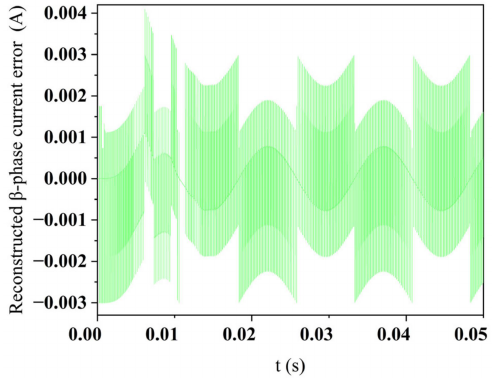
Figure 3. Reconstructed β -axis current error.